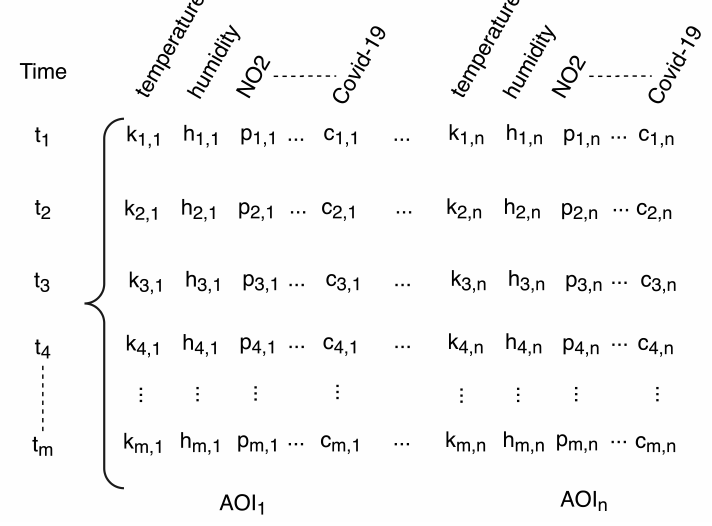
Figure 6. Dataset